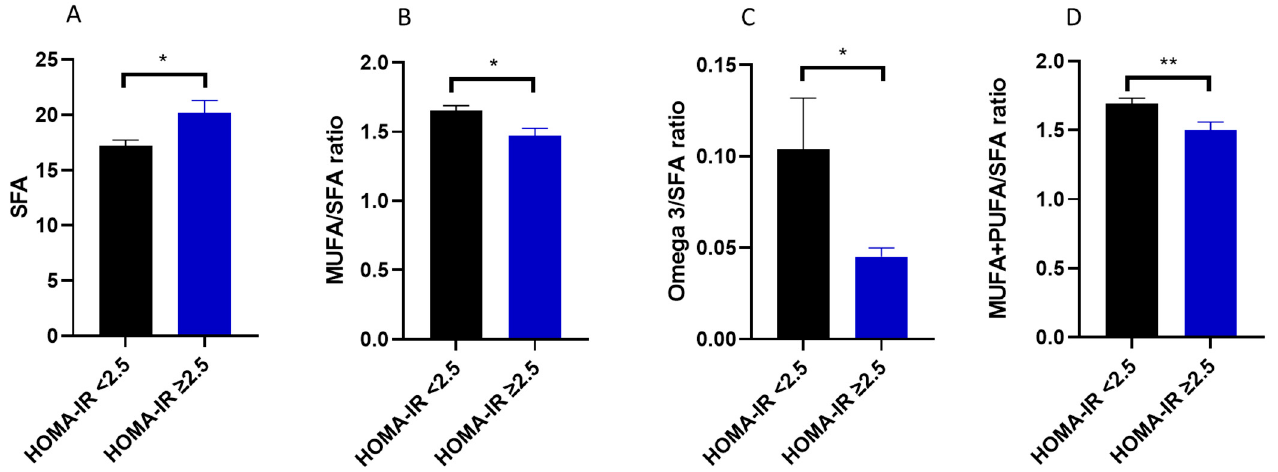
Figure 2. Dietary fa tt y acid quality consumed by individuals with a HOMA-IR either <2.5 or ≥ 2.5. ( A ) Intake of SFA, ( B ) ratio between MUFA and SFA, ( C ) ratio between omega-3 and SFA and ( D ) ratio between MUFA+PUFA and SFA. All data are expressed as mean ± SEM and di ff erences between groups were assessed using Mann–Whitney test. * p < 0.05, ** p < 0.01. SFA, saturated fa tt y acids; MUFA, monounsaturated fa tt y acids; PUFA, polyunsaturated fa tt y acids; HOMA-IR, homeostatic model assessment for insulin resistance.